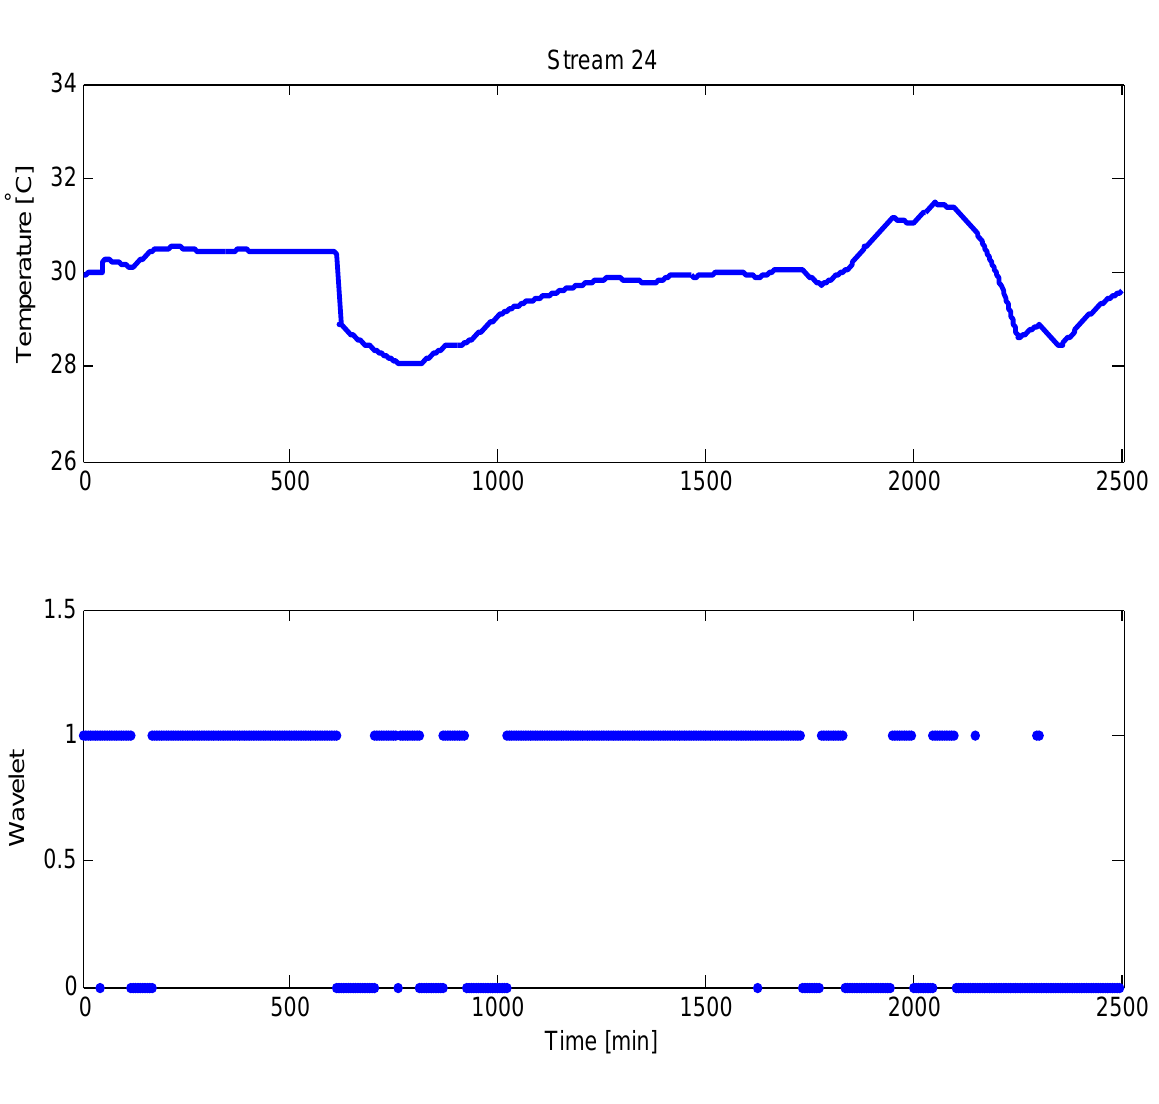
Figure 16. Depropanizer reflux drum case temperature experimental data and SSI results for the wavelet